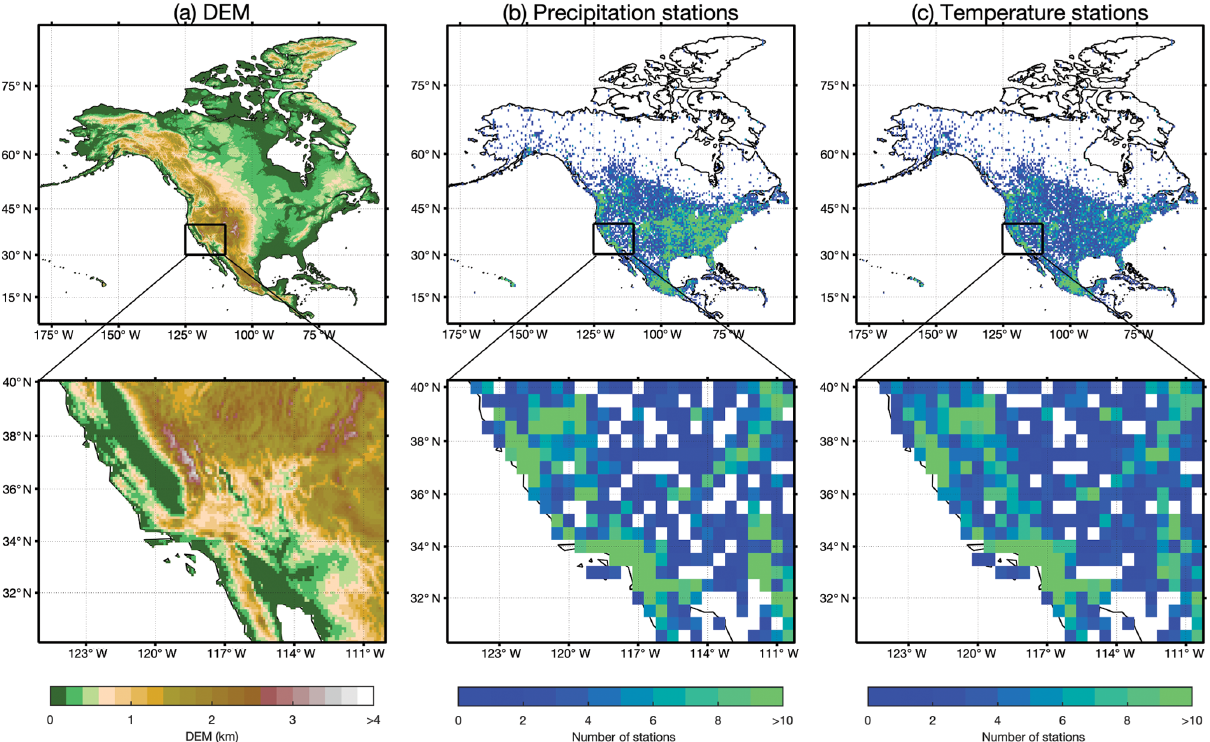
Figure 1. (a) Digital elevation model (DEM; Sect. 2.3) of North America. (b, c) The densities of stations at the 0 . 5 ◦ × 0 . 5 ◦ resolution for precipitation and temperature, respectively. T min and T max stations are highly consistent, and thus T min is used to represent temperature in (c) . The nested black boxes show examples of DEM and station